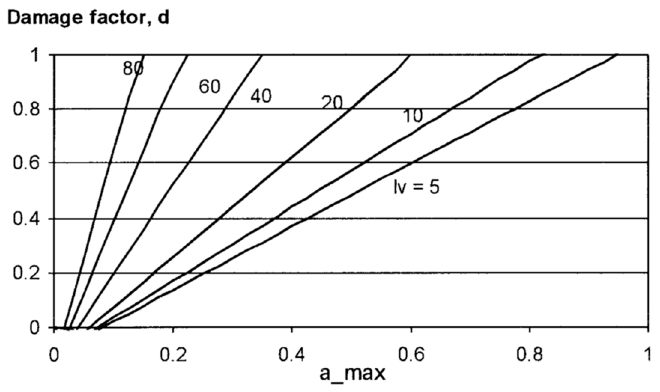
Figure 2. Unified relationships between vulnerability, damage and peak ground acceleration, adapted from Petrini [17].